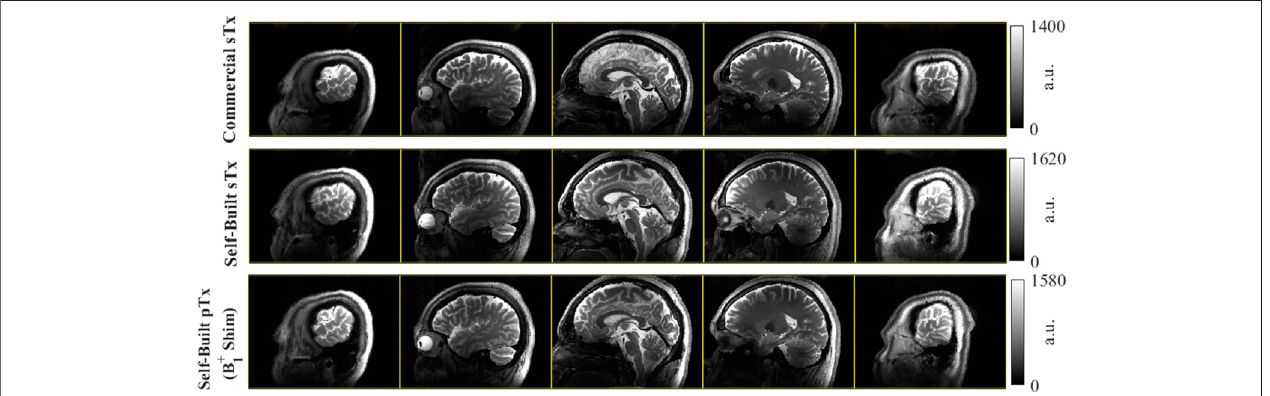
FIGURE 12 | Comparison of dual-mode head coil coverage to commercial single-transmit coil with a sagittal T2w 2D RARE acquisition in the same volunteer. Top row)Acquisitionusingthecommercialcoilatseveralslicelocations;Middlerow).Thesameacquisitionusingthedual-modecoilinsingle-transmitoperation;Bottomrow) The repeated acquisition with the dual-mode coil in parallel-transmit mode, here with complex B 1+ shimming applied. Comparing the commercial Nova coil to the self- built dual-mode coil, there is improved coverage in the inferior regions of the brain. In this example, there are some modest improvements going from sTx to pTx in the dual-mode coil with B 1+ shimming, particularly in the most distal slices (columns 1 and 5).